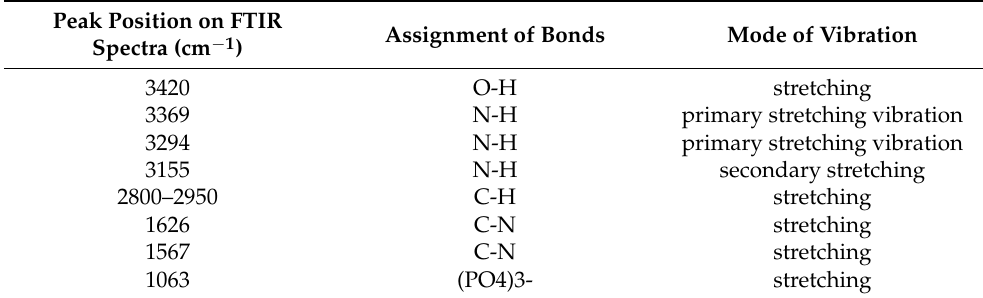
Figure 1. Characterization of Gelatin/Nano-Hydroxyapatite/Metformin scaffold (GHMS). Scanning electron microscopy (SEM) images of GHMS at different magnifications: ( A ) 100× and ( B ) 3500× (right). ( C ) X-ray diffractometry (XRD) patterns of natural bone tissue and GHMS. ( D ) Fourier transform infrared (FTIR) patterns of conventional hydroxyapatite (HAp), gelatin, metformin (MET), and GHMS (Table 1). Table 1. Functional groups and mode of vibration from FTIR spectra of the GHMS.